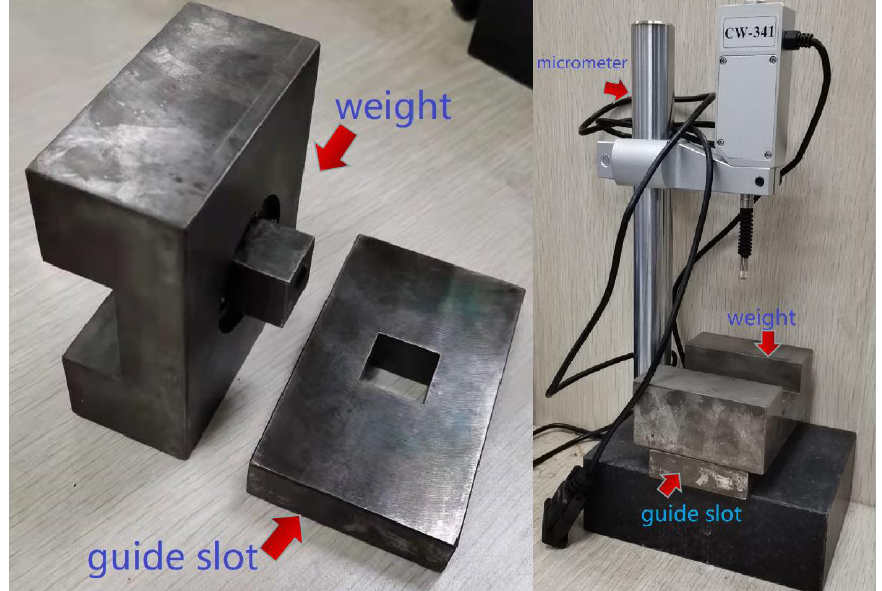
Figure 4. Prepreg creep curve measuring device.